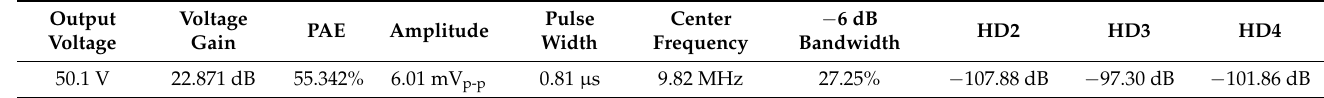
Table 1. Performance summary of the designed inverse Class-E power